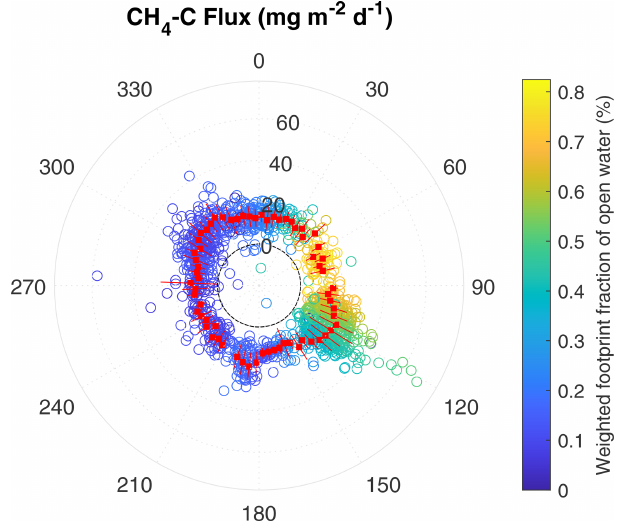
Figure 5. Polar plot of 30min observed CH 4 –C flux with respect to the wind direction at the EC tower. Positive values outside the dashed black line represent CH 4 emissions, while values inside the line represent CH 4 uptake during one half-hour period. The val- ues 0, 20, 40, and 60 indicate the magnitude of the CH 4 –C flux in mgm − 2 d − 1 . The color of each point on the plot represents the per- centage the point comprises of the total open-water weighted foot- print fraction in each 30min flux. The red boxes indicate the mean CH 4 flux of 5 ◦ wind direction intervals during the 2-month obser- vation period (red lines indicate the first standard